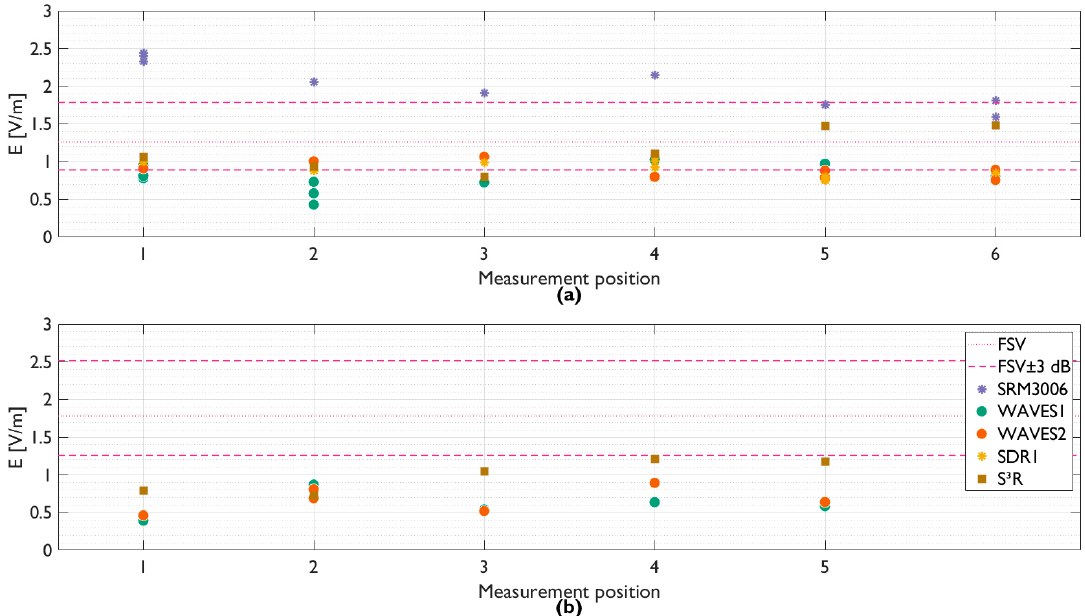
Figure 5. Result of in-situ testing at green village in Delft. Hardware sensors and SDR were compared to the baseline (i.e., FSV). The measurement positions (1 to 5/6) correlate with the positions indicated in Figure 3. ( a ) Horizontal configuration of Figure 3c,d; ( b ) Vertical configuration of Figure 3a,b. Red line: FSV (±3 dB is also shown because of uncertainty of SA setup [11]).